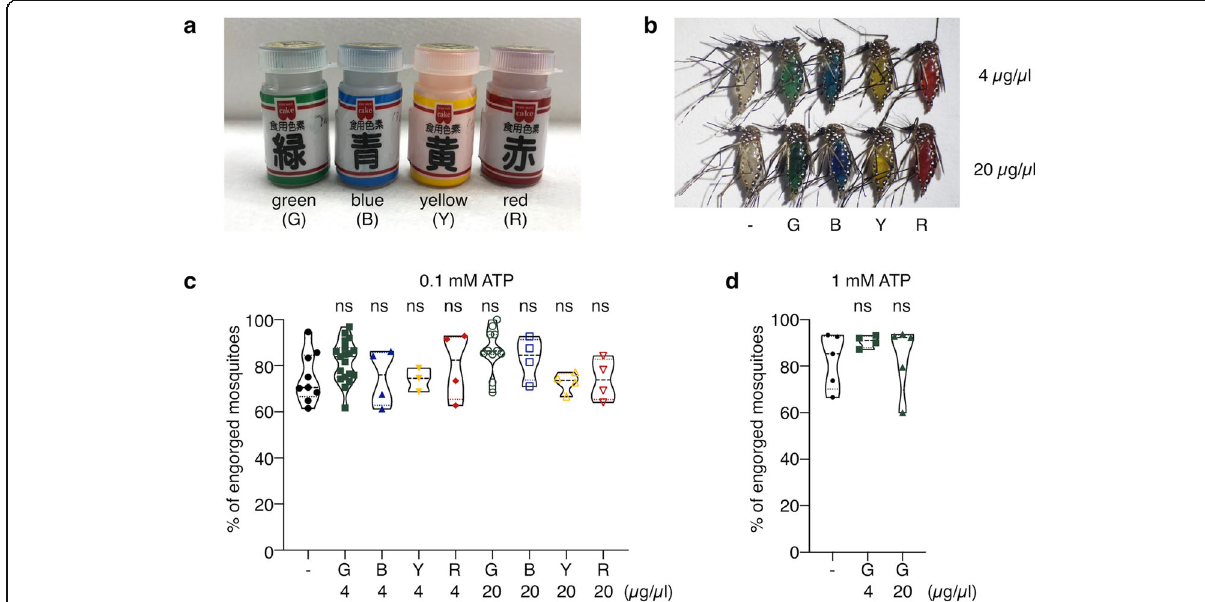
Fig. 1 Food dyes colorize mosquito abdomen using ATP-based membrane feeding. a Food dyes used in this study. b A representative example of Ae. aegypti female mosquitoes that sucked 0.1 mM ATP solution containing 4 μ g/ μ l (upper row) or 20 μ g/ μ l (lower row) of each food dye. -, G, B, Y, and R indicate no food dye (control), green, blue, yellow, and red, respectively. c , d Ae. aegypti female mosquitoes engorged with 0.1 mM ( c ) or 1 mM ATP ( d ) solution containing the indicated concentration of each food dye. All experiments were performed more than three times. Dunnett ’ s multiple comparison test; ns, not significant of measured absorbance of diluted green dye (20 μ g/ μ l) optimal wavelength for measuring absorbance of the derived a formula to estimate the volume of the solution green dye used in this study. The absorption spectrum ingested by a mosquito (Fig. 3c). In the case of the mos- of the green dye showed one of the broad peaks of ab- quitoes fed on the ATP solution containing 20 μ g/ μ l sorption corresponding to a maximum around 638 nm green dye (as shown in Fig. 3b), the estimated volume (see “ Methods ” ), followed by measuring the absorbance was calculated as 2.775 μ l, in agreement with previous of serial dilution of the dye at 638 nm (Fig. 3a). Superna- reports [17, 19, 20]. tants prepared from homogenized mosquitoes that were fed with ATP solution containing 4 or 20 μ g/ μ l green dye were then analyzed, resulting that the absorbance at Estimation of the volume of ATP solution in mosquito by 638 nm was also proportional to the concentration of naked eye green dye even after the dye was ingested by mosquitoes The colored abdomen of a mosquito is easily visible to (Fig. 3b). Simple linear regression analysis with the result the unaided eye (Fig. 1b). To investigate whether the